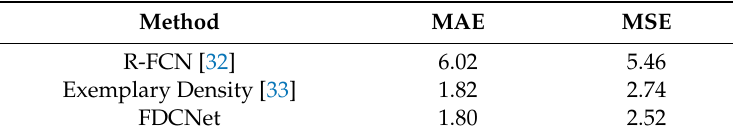
Table 5. The estimation errors on Mall